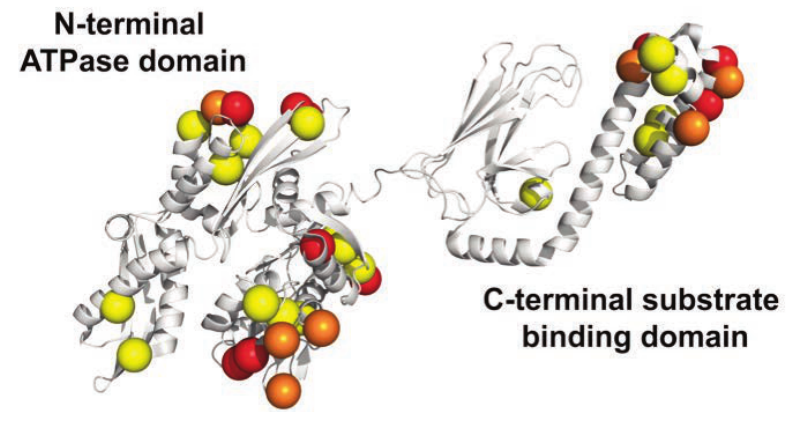
Figure 2. 3D structure of hsp70 from M. galloprovincialis . The location of mutated residues from A. ater are shown. Yellow and orang e spheres represent conservative and semi-conservative substitutions. In red , non-conservative substitutions.